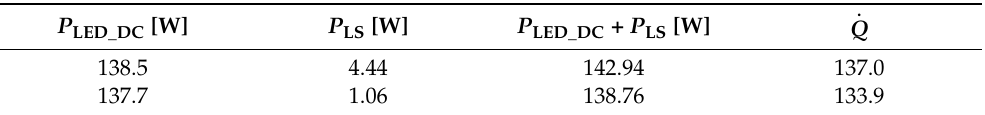
Table 2. The thermal balance of the shaded LED lamp.